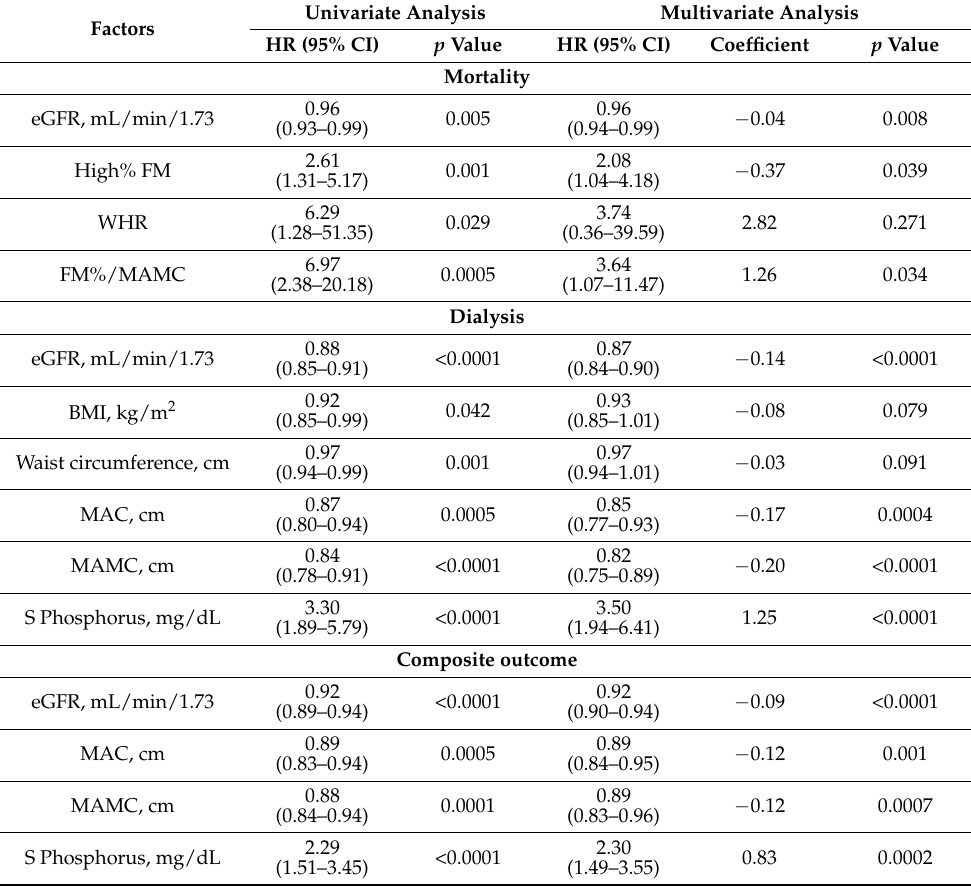
Table 3. Conditions associated with: (A) mortality, (B) dialysis and (C) composite outcome, in univariate and multivariable Cox regression model adjusted for baseline covariates (age, gender and presence of type 2